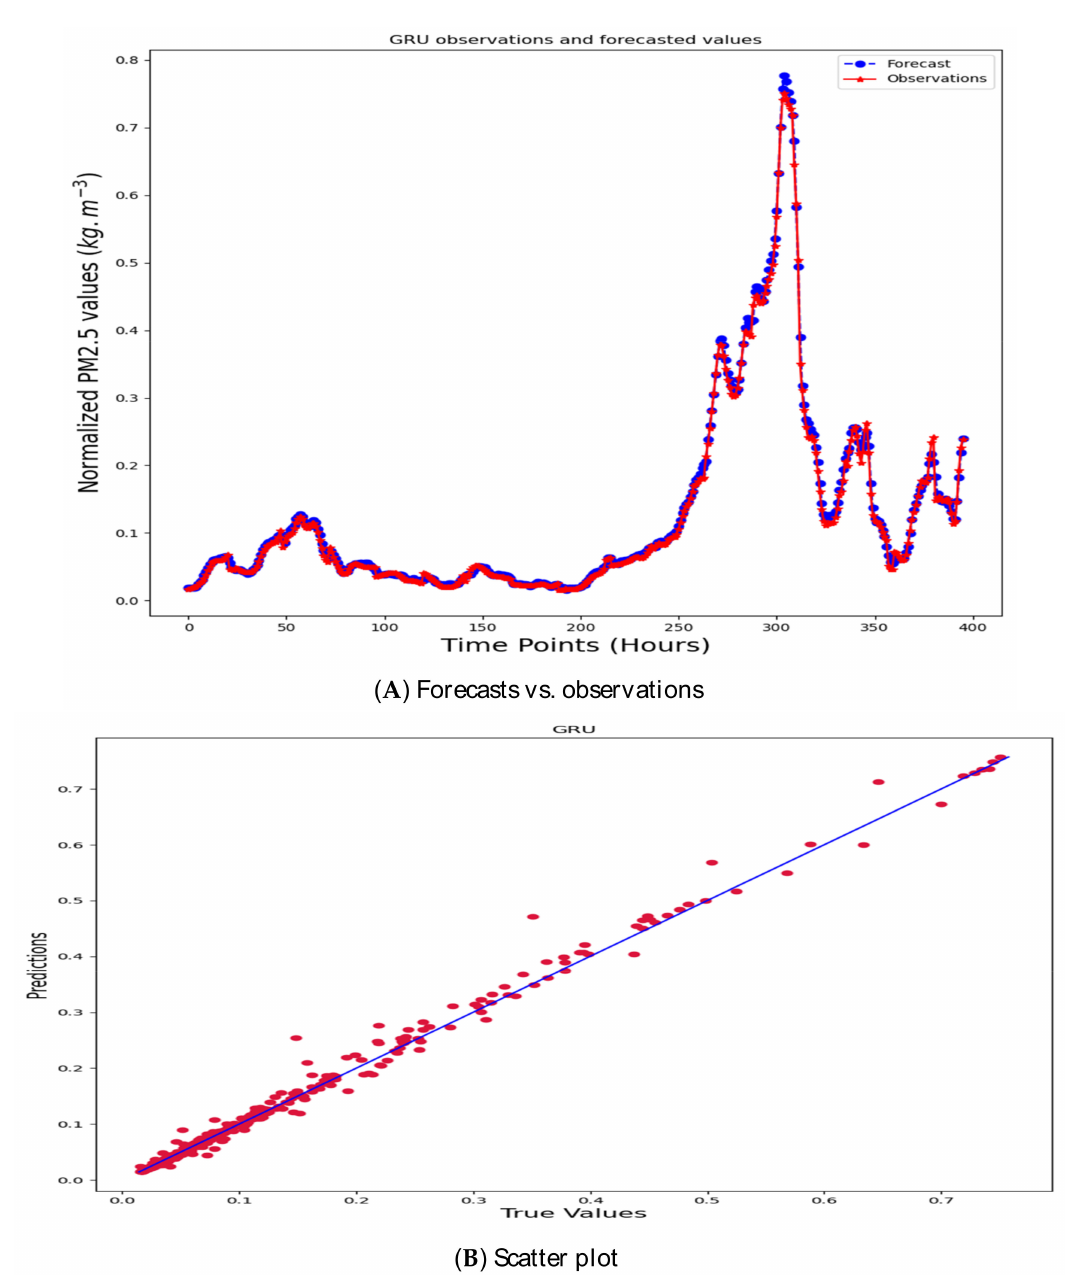
Figure 5. Forecasting results of